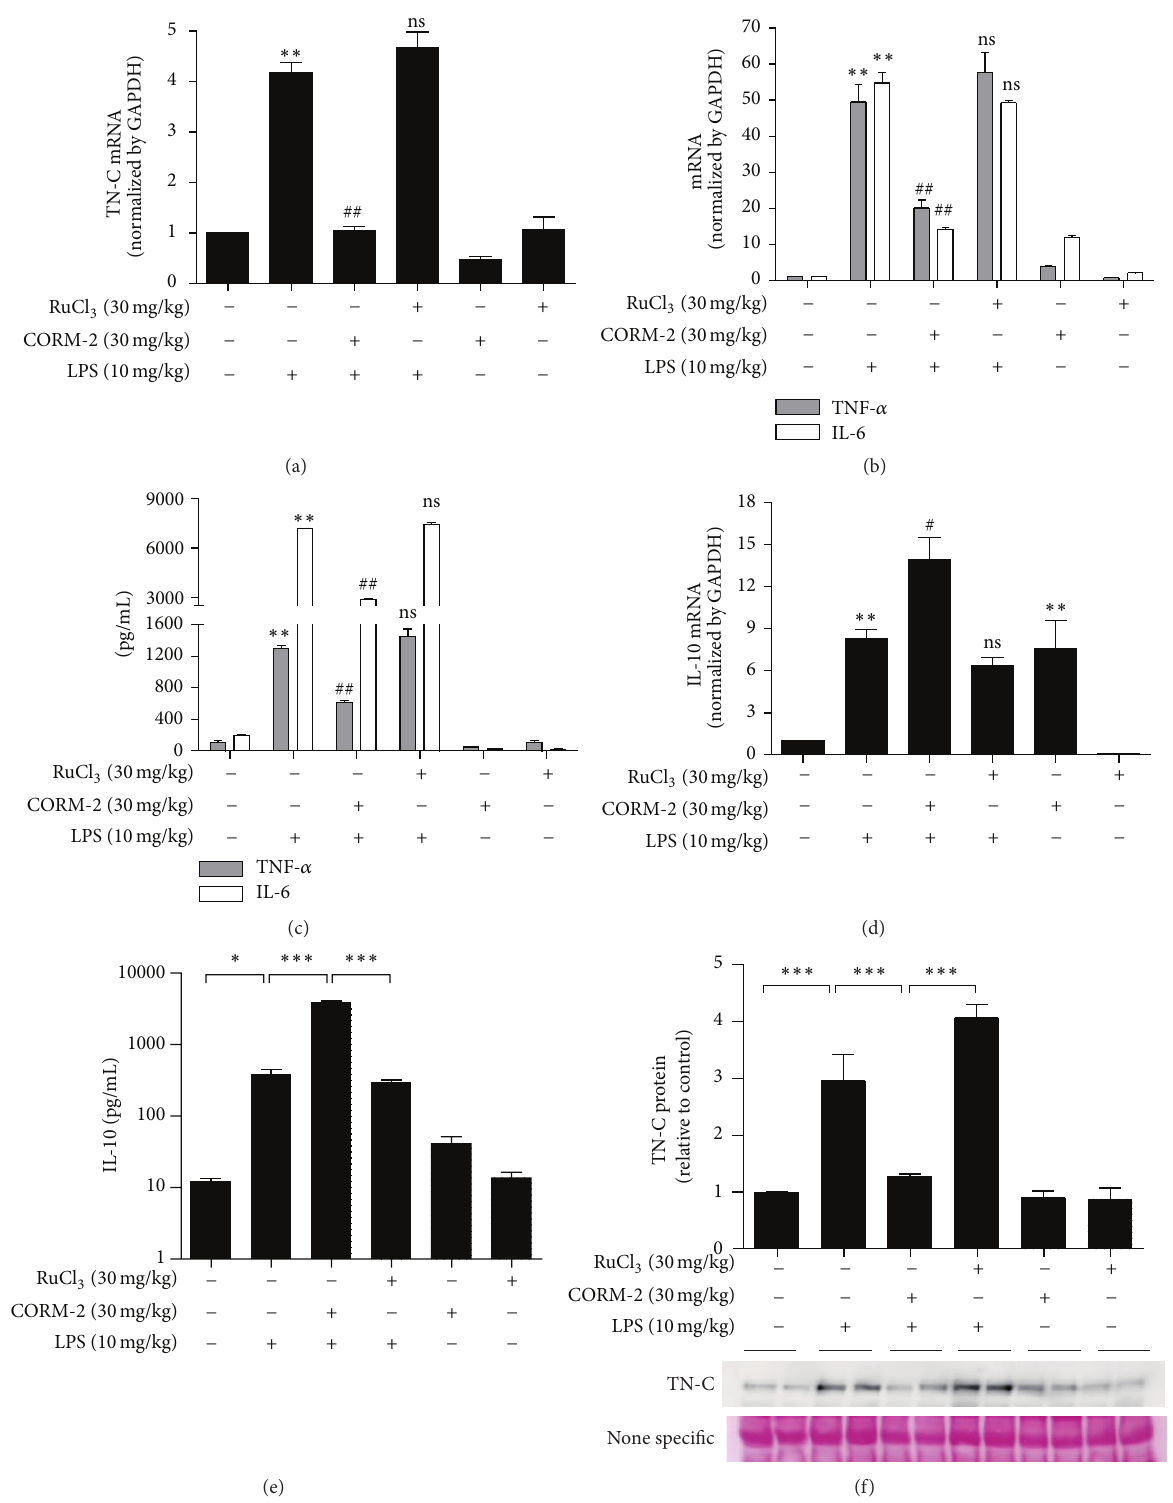
Figure 5: CO inhibits TN-C-mediated inflammation a septic mouse model. Wild type seven-week-old male C57BL/6 mice were pretreated with CORM-2 (30 mg/kg, i.p.) or RuCl 3 (30mg/kg, i.p.) for 2 h and then mice were injected with LPS (10mg/kg, i.p.) for 2 h. Liver tissues were analyzed for mRNA levels of TN-C (a) and TNF- 𝛼 and IL-6 (b) by Real Time RT-PCR. Blood serum was analyzed for protein expression of TNF- 𝛼 , IL-6 (c). IL-10 mRNA (d) by Real Time RT-PCR and IL-10 protein (e) by ELISA were measured. The protein levels of TN-C from serum were measured by Western blotting (f). Loading control was detected by ponceau staining. The relative signal intensity of bands was determined and standardized using ImageJ software. Data represents mean ± SEM, ∗ 𝑃 < 0.05 , and ∗∗ 𝑃 < 0.001 when compared with control; # 𝑃 < 0.05 , ## 𝑃 < 0.001 , and ns, nonsignificant, as compared with the cells exposed to LPS